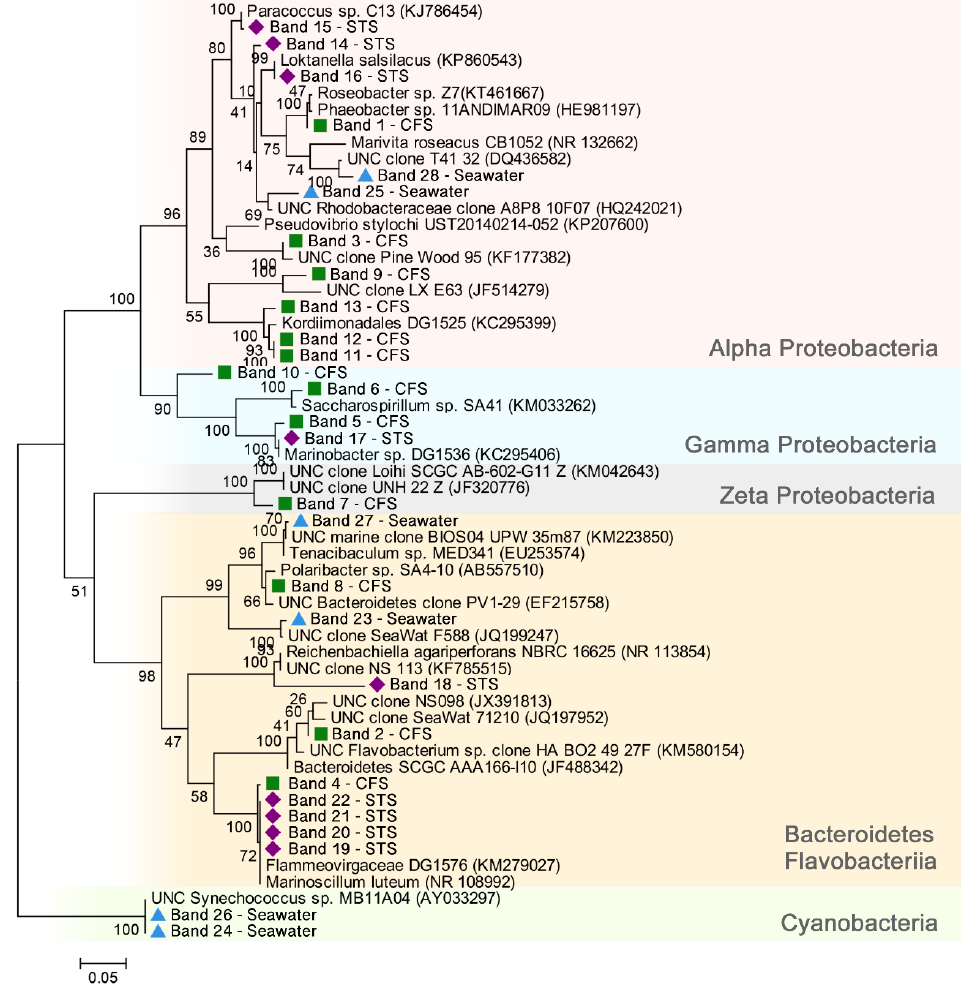
Figure 3. Phylogenetic analysis of the selected DGGE strains. Molecular phylogenetic analysis based on partial sequences of the 16S rRNA gene selected by the maximum likelihood estimation method. The tree with the highest log likelihood (–4806.8854) is shown. The numbers at the left-hand side of each tree branch indicate the percentage of taxa clustered together in the branch.